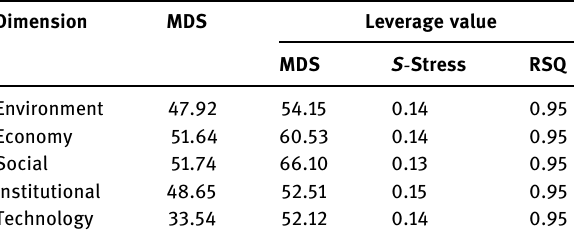
Table 5: The results of leveraging 11 indicators on all dimensions of sustainability Dimension